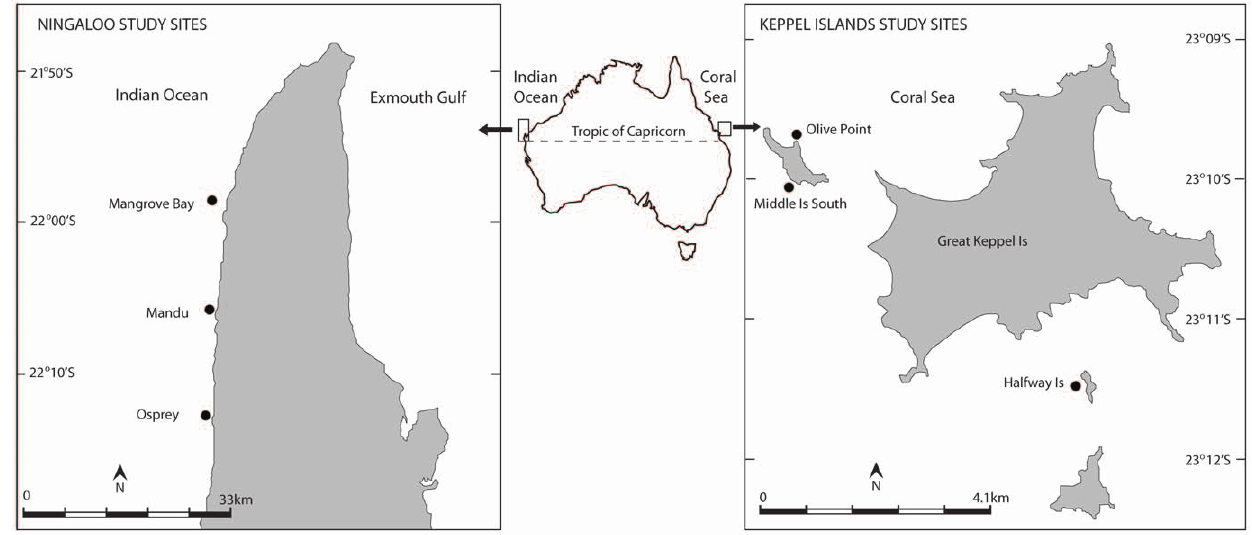
Figure 1. Map of the two study regions, the Keppel Islands in the southern Great Barrier Reef and Ningaloo Reef, showing the location of the study sites.